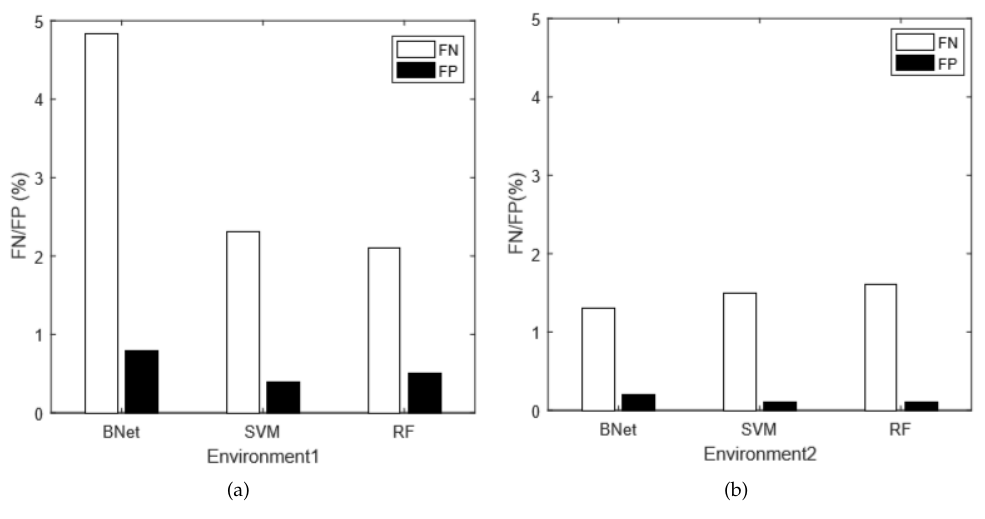
Figure 9. The FN/FP ratios on different